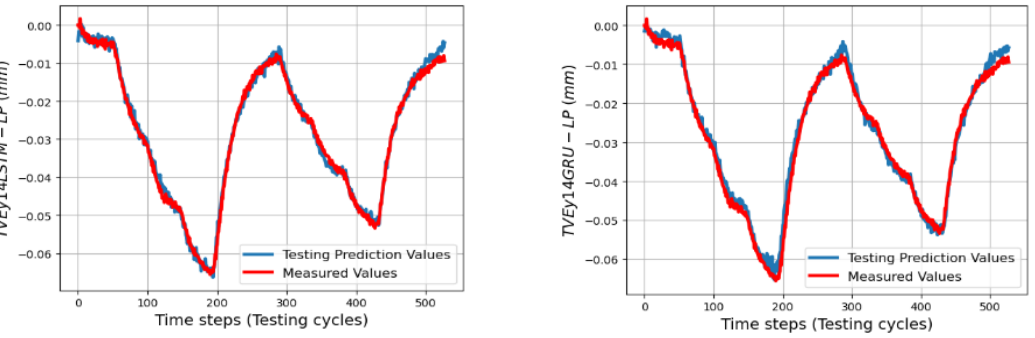
Figure 26. Prediction of TVEy14 by SLSTMs and SGRUs in the long process (LP) (1 cycle = 15 min) .